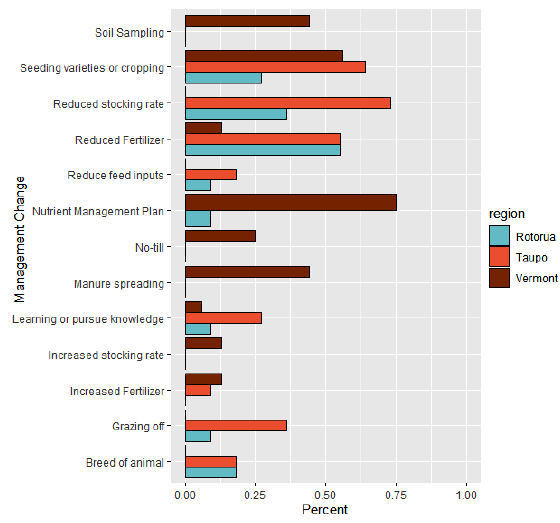
Fig. 2 . Percentage of sample reporting management changes by region.